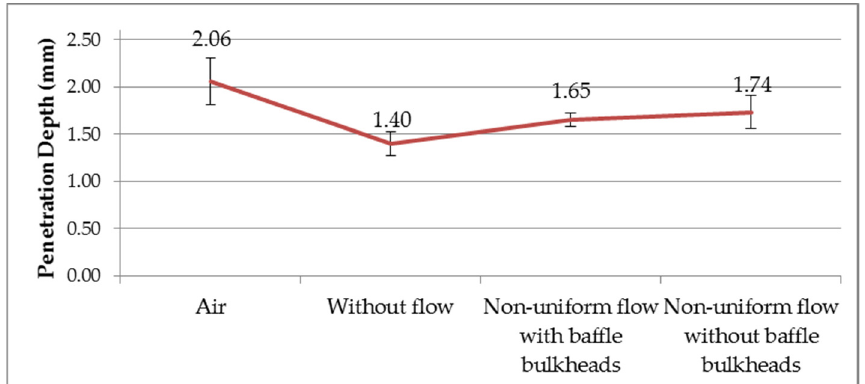
Figure 5. Observation results for air welding, flowless welding, non-uniform flow with a baffle bulkhead, and non-uniform flow without a baffle bulkhead.